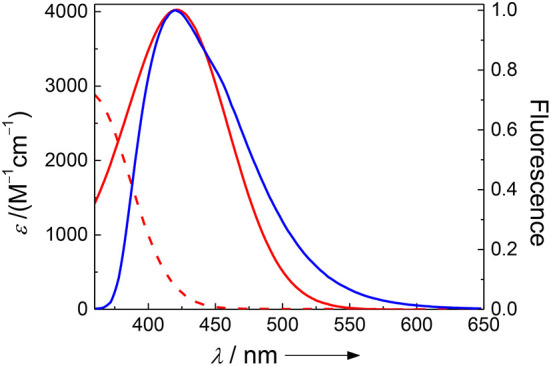
Spectral overlap between the pH-independent emission of Dbo (blue) and the absorption of 3-nitrotyrosine (red) at pH 2 (dashed line) and pH 8 (solid line).